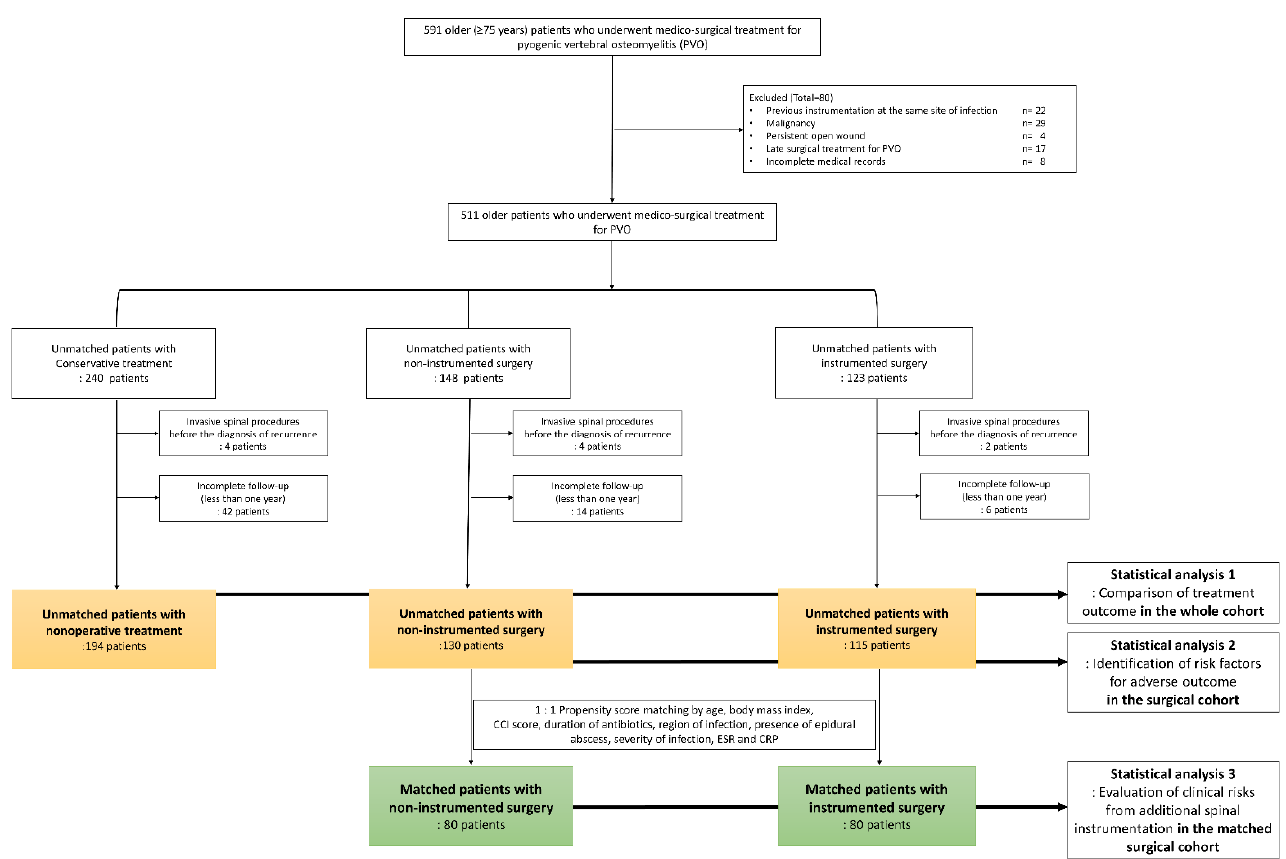
Figure 1. Patient enrollment.